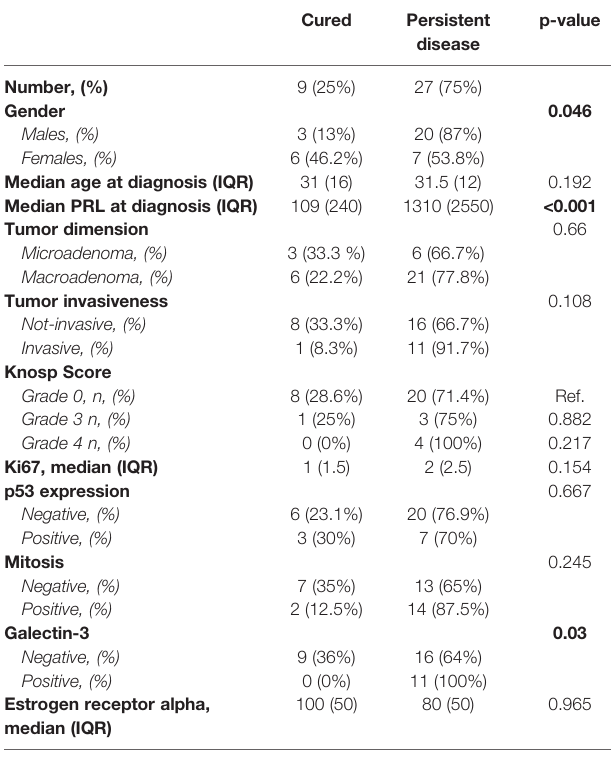
TABLE 2 | Predictors of recurrence/progression disease.